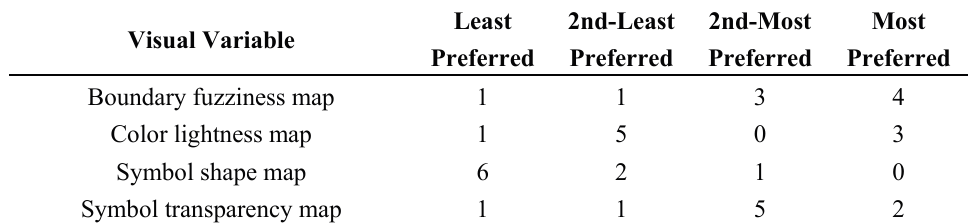
Table A2. Number of preference ranking for the four maps by participants in neither group.